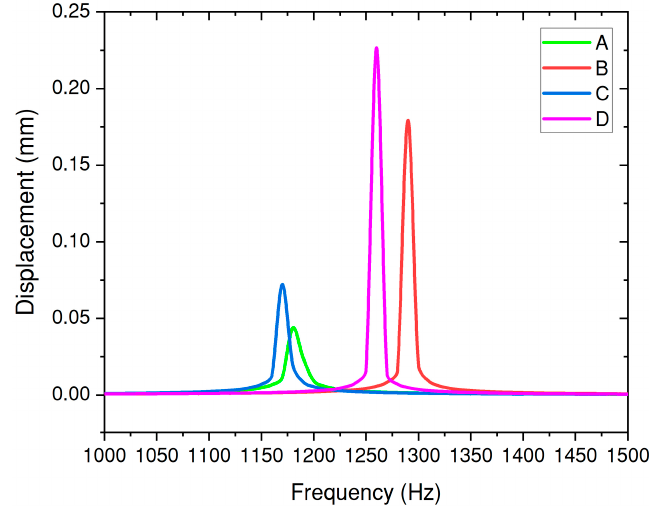
Figure 13. Comparison curve of total displacement response of end milling cutter.